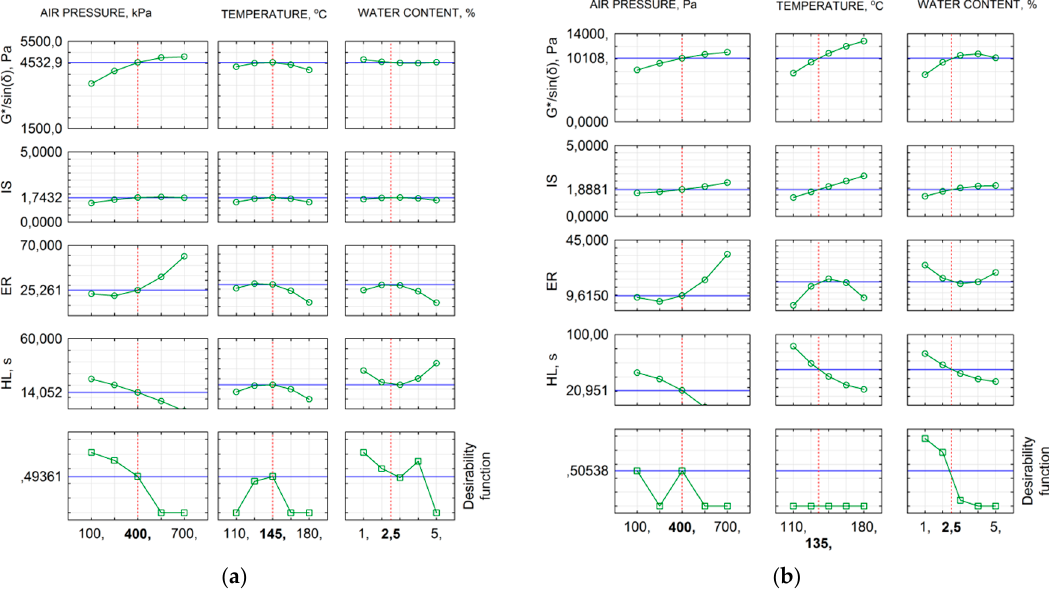
Figure 11. Optimisation outcomes: ( a ) bitumen 50/70; and ( b ) bitumen 50/70 M (2.5% FT wax).